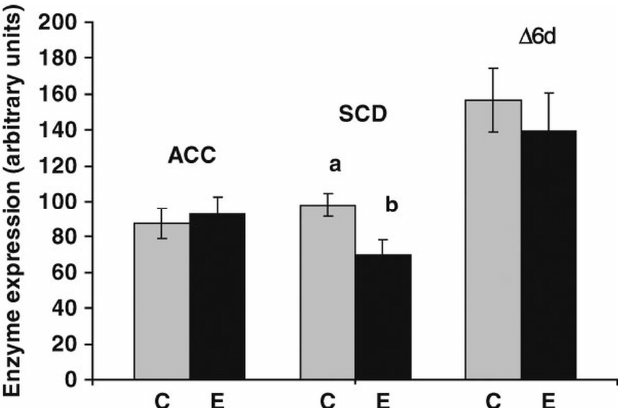
Figure 6. Effects of colza supplementation on the expression of acetyl-CoA carboxylase ( ACACA ), stearoyl-CoA desaturase ( SCD1 ) and ∆ 6-dessaturase ( ∆ 6d ) genes in the longissimus muscle. C = control